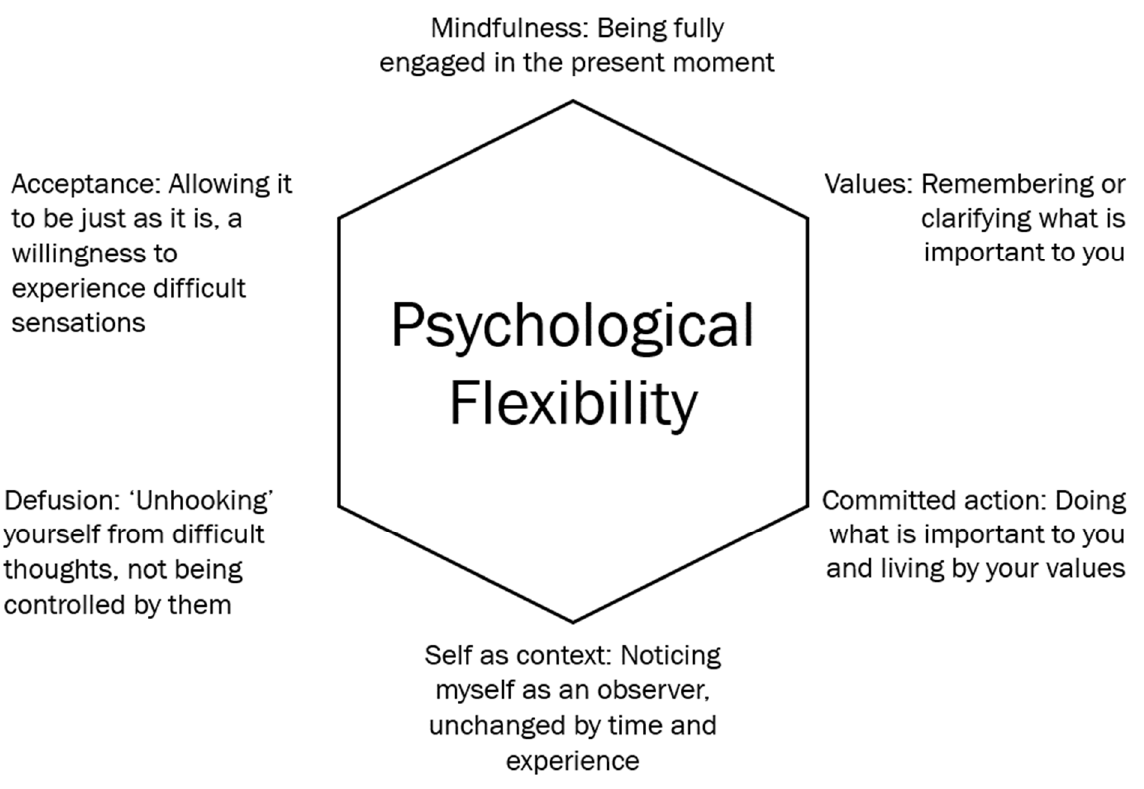
Figure 1. The framework of Acceptance and Commitment Therapy.